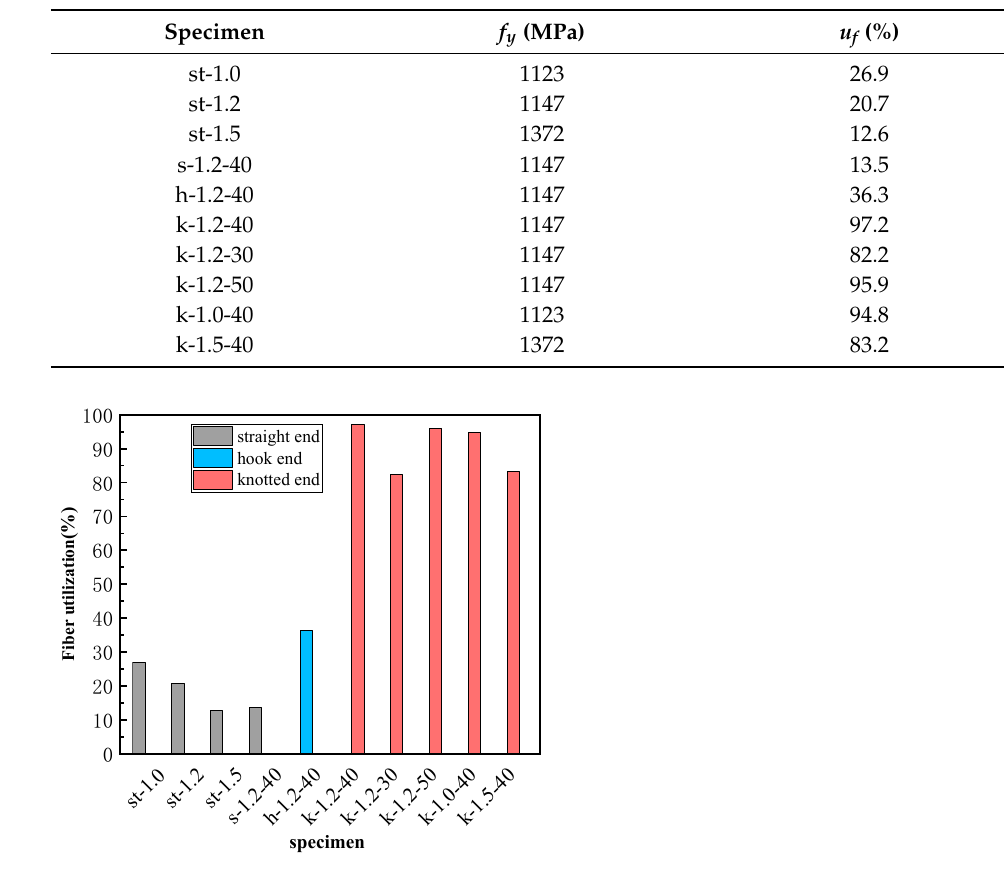
Table 6. The SMA strength utilization rate of test specimens.